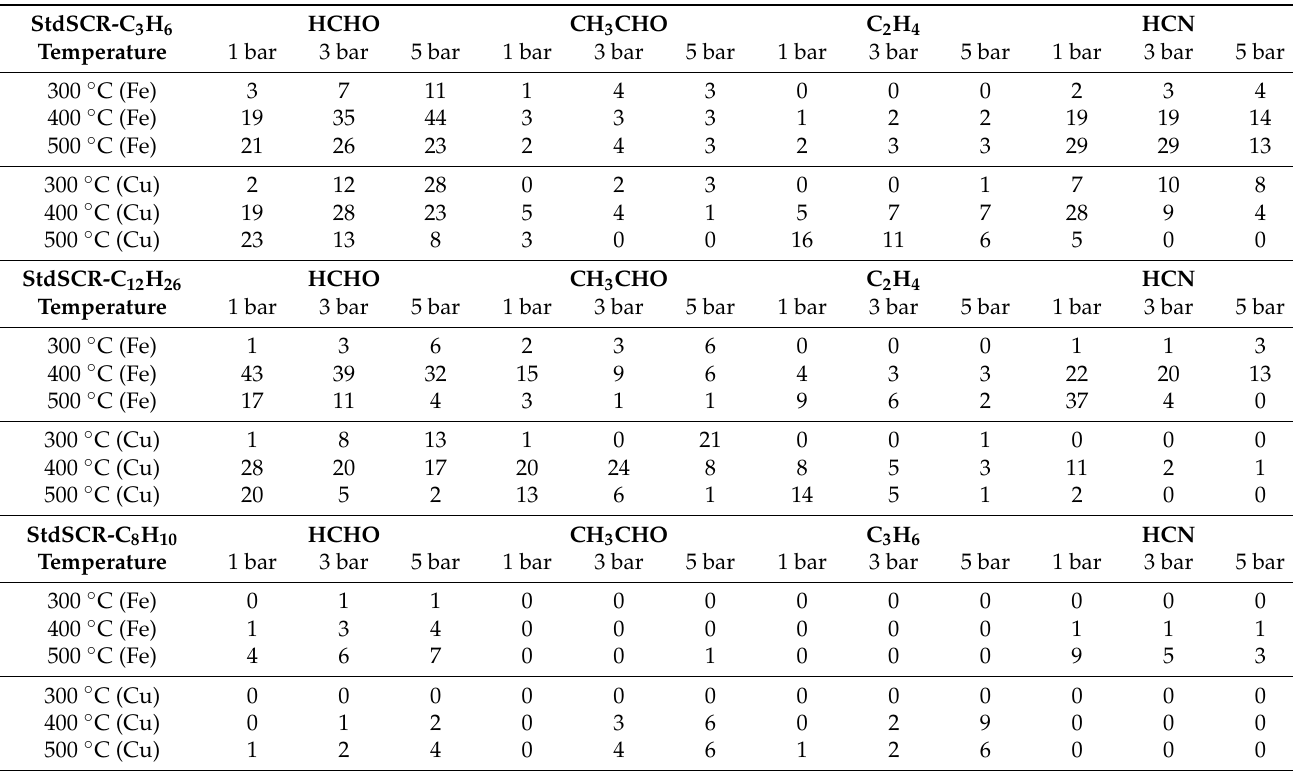
Figure 3. Hydrocarbon conversion by oxidation of 200 ppm C 3 H 6 (left), 50 ppm C 12 H 26 (middle) and 75 ppm C 8 H 10 (right) during C x H y oxidation (line) and standard SCR (dashed) over Fe-ZSM-5 (top) and Cu-SSZ-13 (bottom) at 1, 3 and 5 bar pressure. Overview table of minor carbonaceous emissions (given in ppm) during standard SCR in presence C 3 H 6 /C 12 H 26 /C 8 H 10 at 1, 3 and 5 bar pressure over Fe-ZSM-5 (Fe) and Cu-SSZ-13